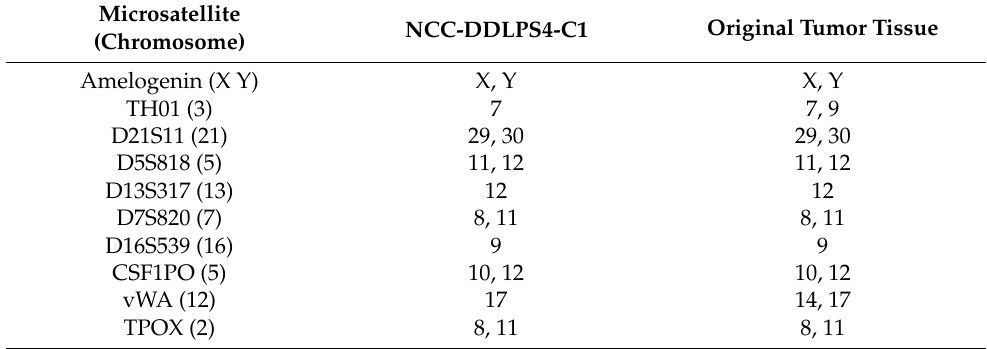
Table 1. Short tandem repeat analysis.